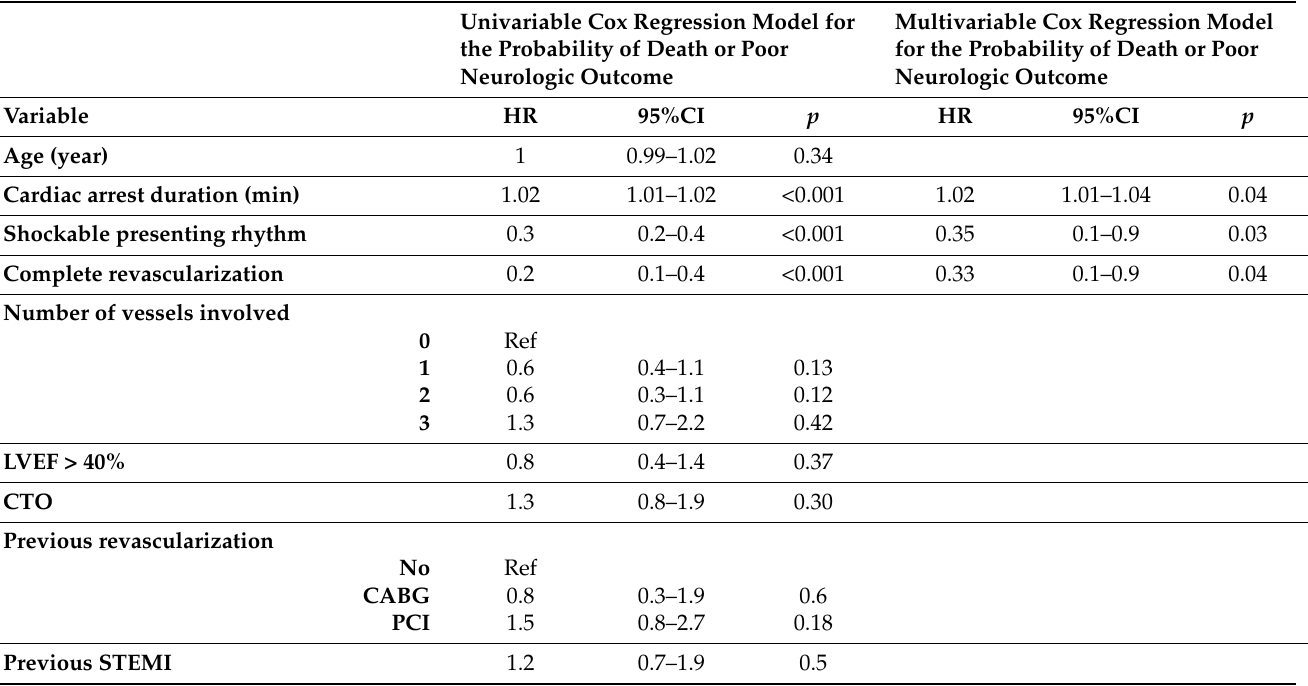
Multivariable Cox Regression